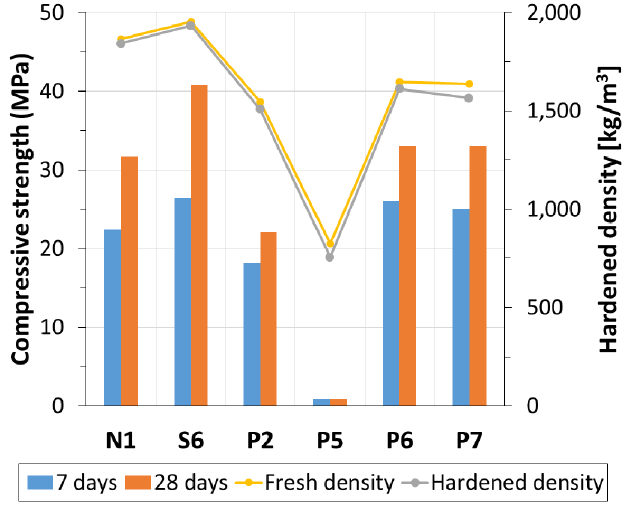
Figure 7. Compressive strength and density of lightweight concrete.